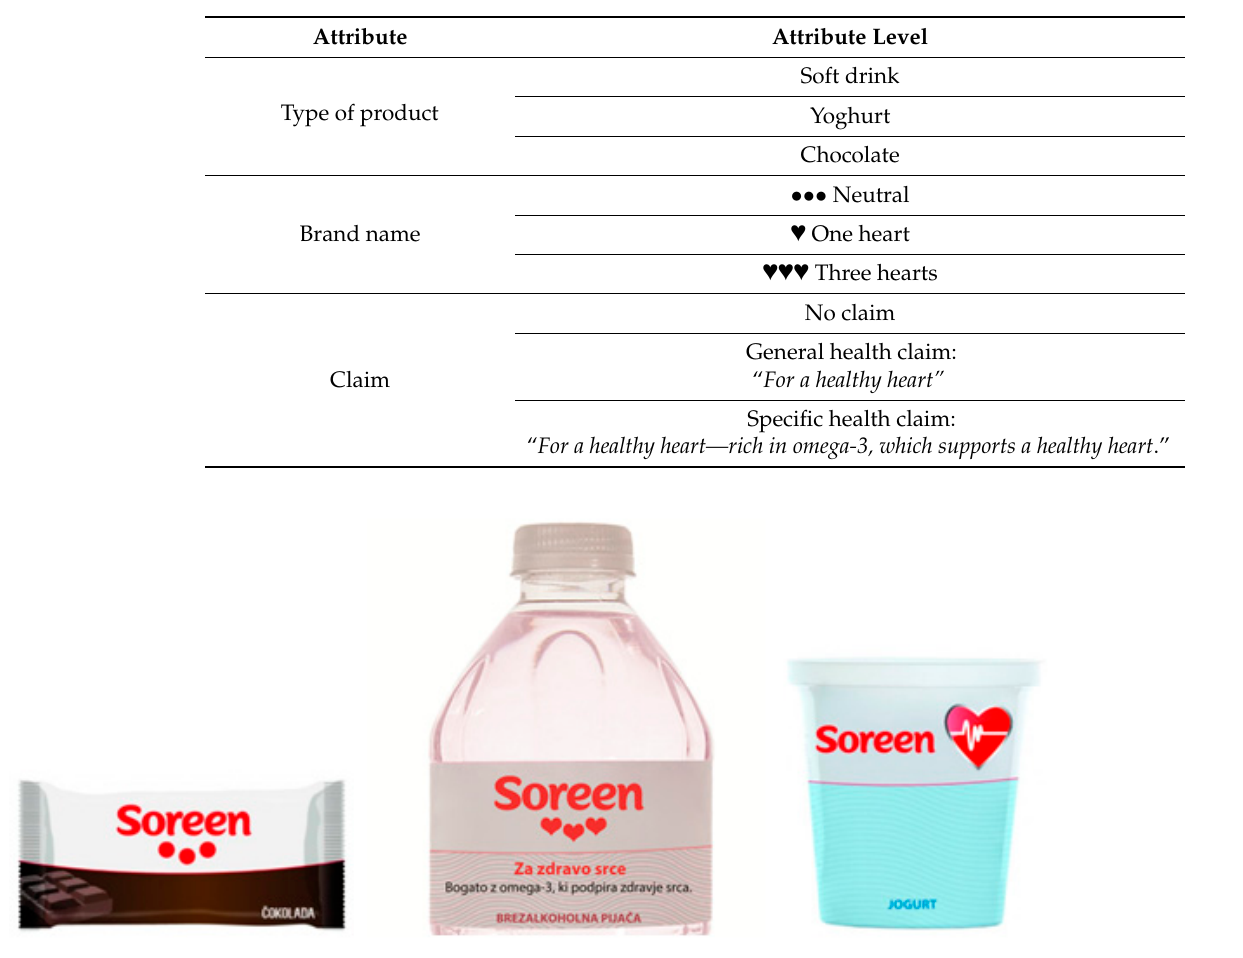
Table 2. Attributes and attribute levels used in the conjoint analyses task.